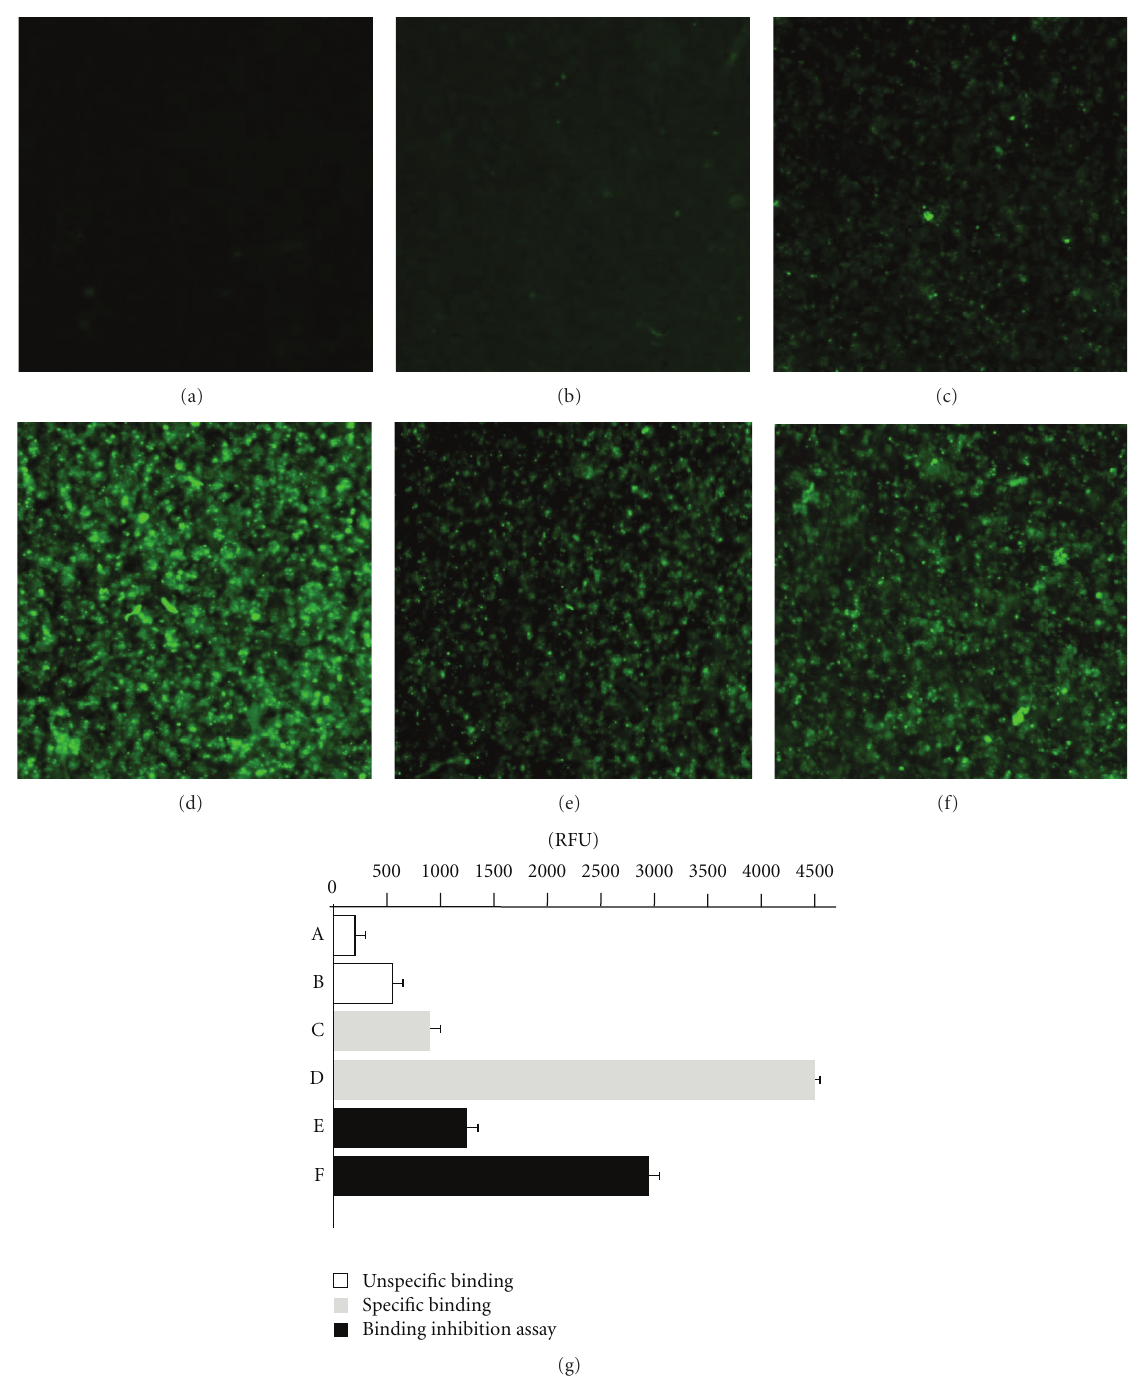
Figure 3: The cell imaging and fluorescence intensity reflecting the interactions between soluble synthetic Le X and Le Y determinants with DC-SIGN receptor on THP-1 leukemia cells, in the immunofluorescence assay. Control THP-1 cells, nondi ff erentiated (a) or di ff erentiated (b) with PMA, GM-CSF and IL-4 stained with FITC-conjugated sheep antibodies against mouse Igs (secondary Ab). Nondi ff erentiated (c) and di ff erentiated (d) THP-1 cells stained with mouse anti-DC-SIGN monoclonal antibodies (mAb) and with FITC-conjugated secondary Ab. Di ff erentiated THP-1 cells preincubated with synthetic Le X (e) or Le Y (f) determinants before the staining of the cells with anti- DC-SIGN mAb followed by the treatment with FITC-conjugated secondary